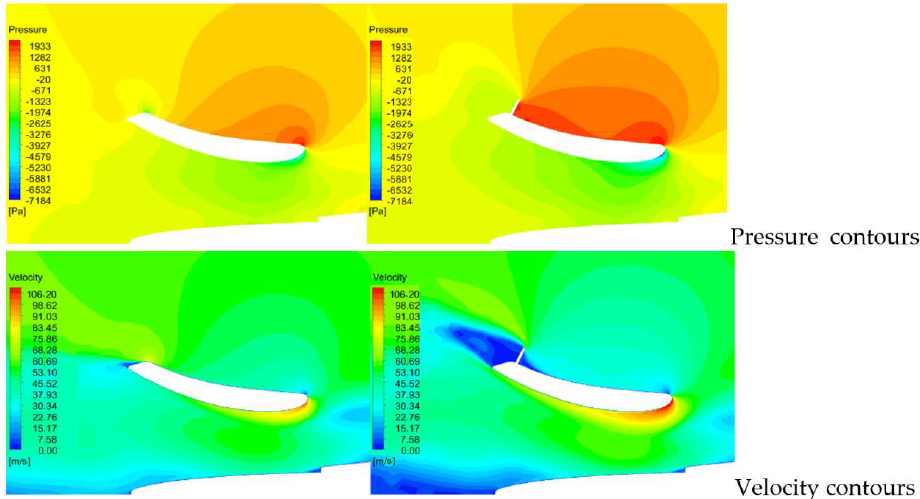
Figure 16. Pressure and velocity distributions around the spoiler without the Gurney flap and with the flap extended when the spoiler is set at 10 degrees.